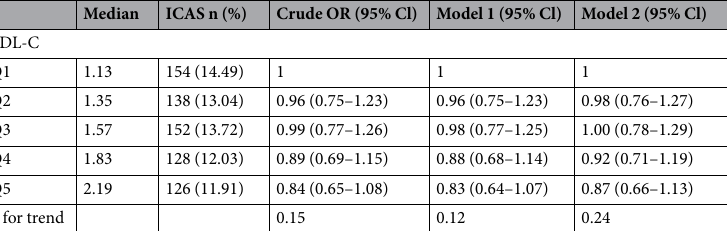
Table 2. Ratio of odds (95% confidence interval) for ICAS based on baseline HDL-C level quintiles. HDL-C: high-density lipoprotein cholesterol. * Model 1: adjusted for gender and age. Model 2: adjusted for gender, age, hypertension, DM, BMI, SBP, DBP, FBG, smoking, physical activity, family history of myocardial infarction, TC, and